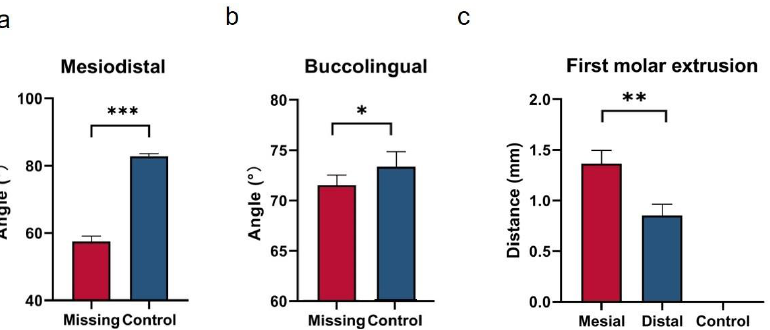
Figure 5. ( a ) Mesiodistal angulation of the mandibular second molar in missing group and control group. ( b ) Buccolingual angulation of the mandibular second molar in missing group and control group. ( c ) Extrusion of the maxillary first molar in missing group and control group. * indicates p < 0.05, ** indicates p < 0.01, *** indicates p < 0.001.